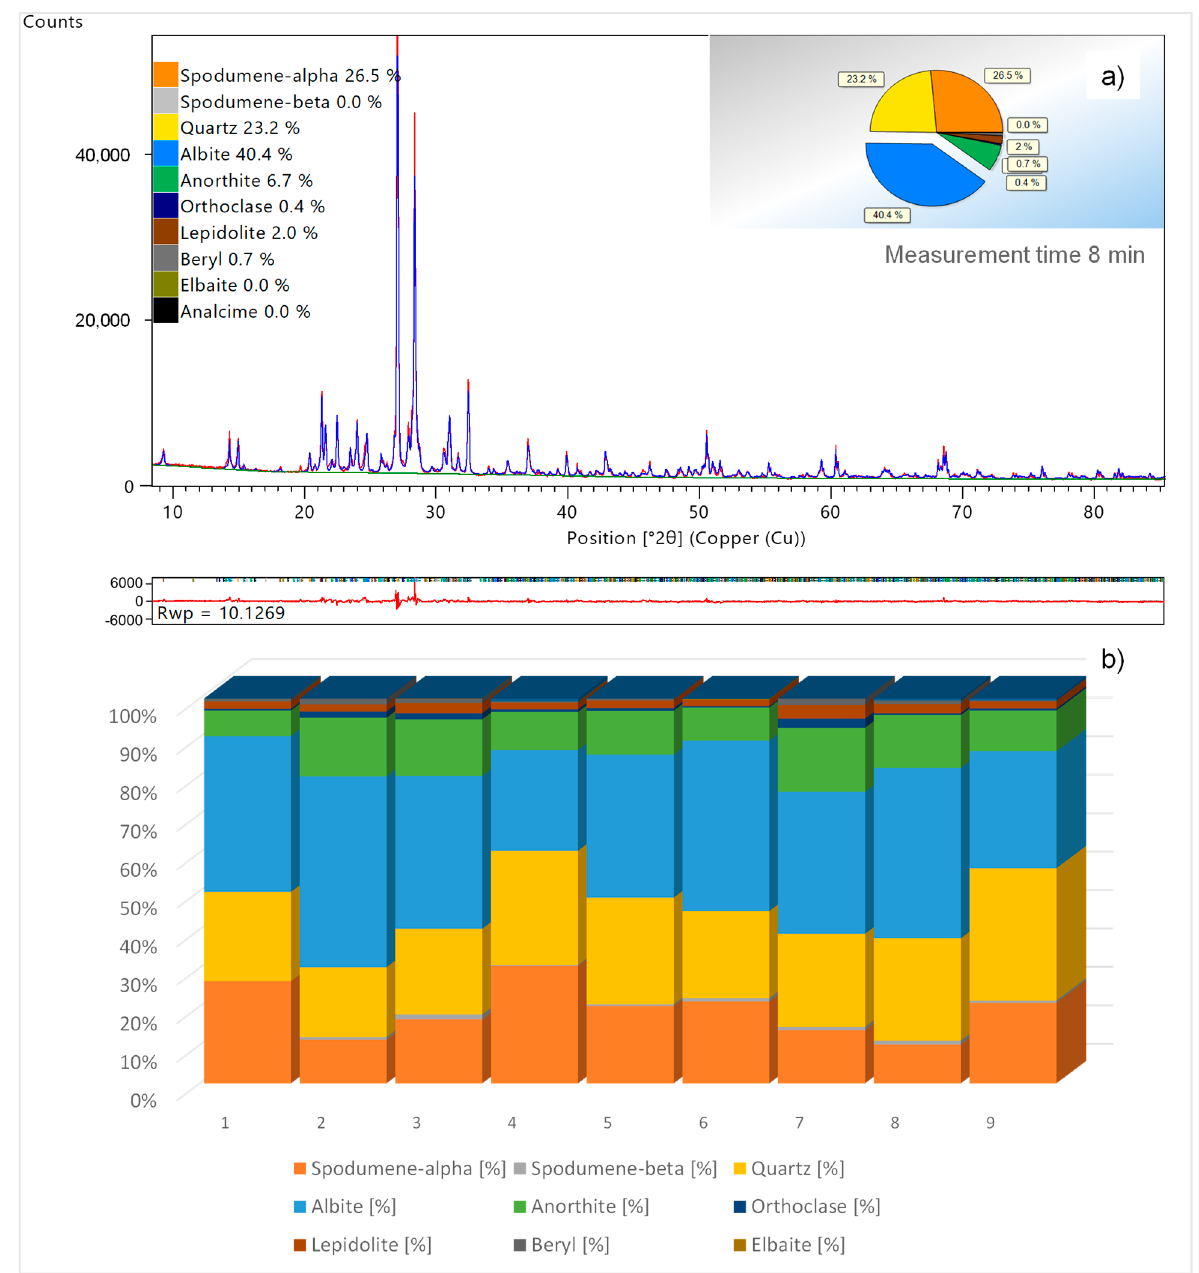
Figure 37. Example of a full-pattern Rietveld quantification of a complex hard-rock lithium ore ( a ) and variation of mineral quantities in the different products ( b ).